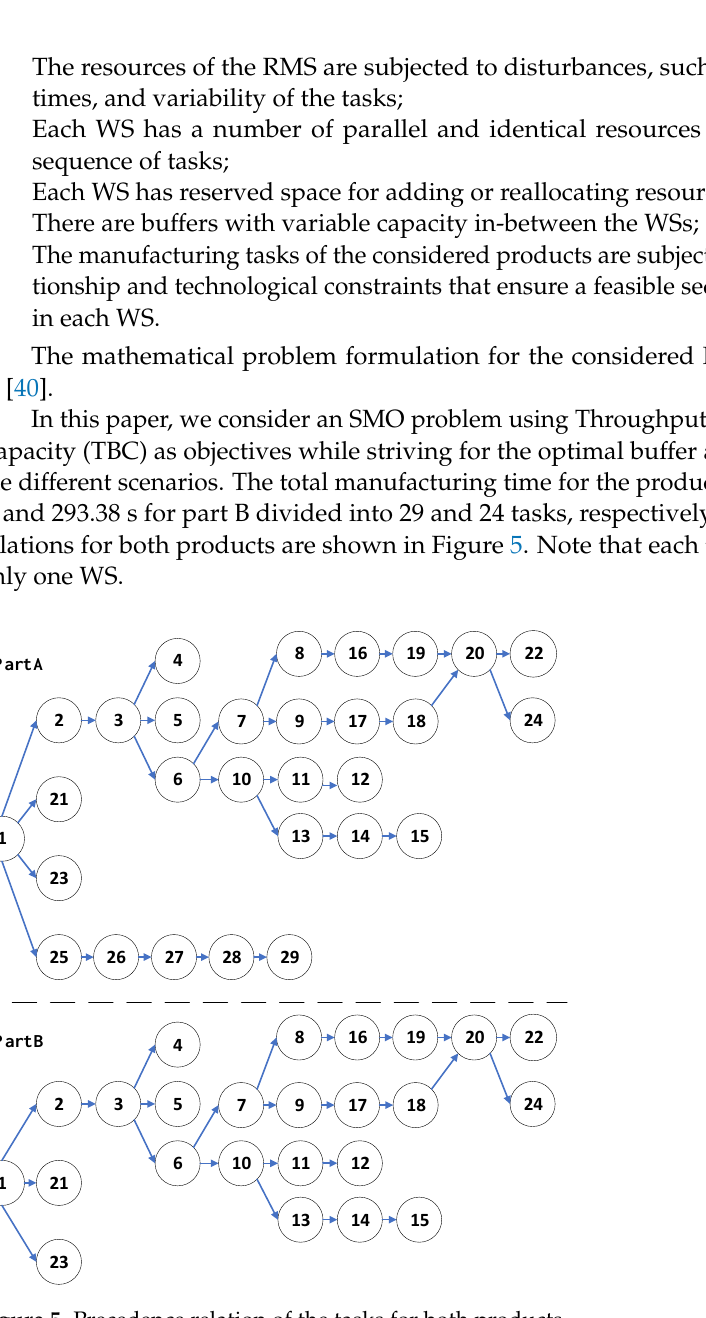
Figure 5. Precedence relation of the tasks for both